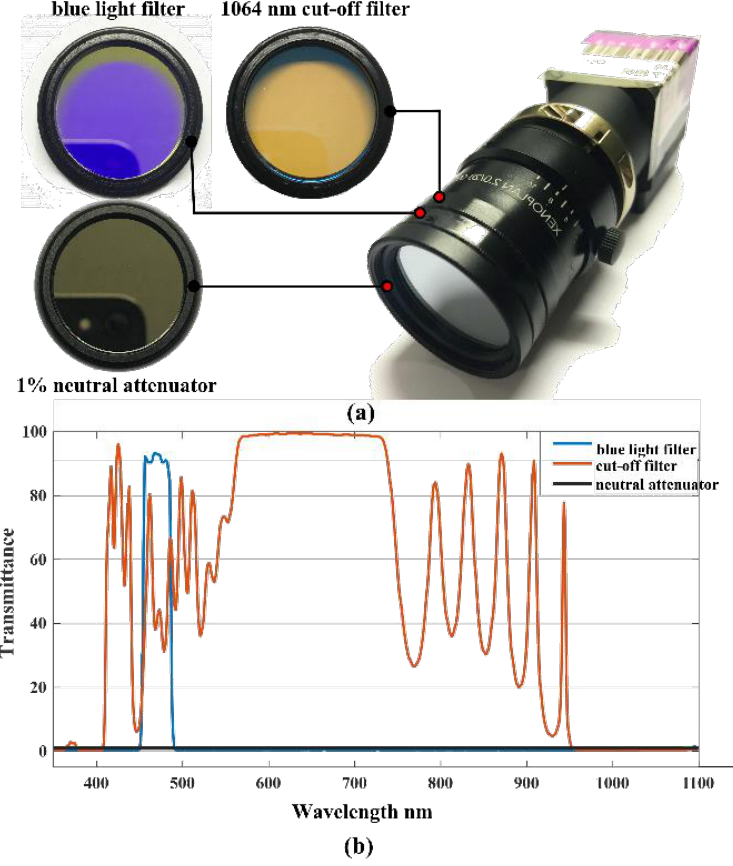
Figure 5. Filter group: ( a ) filter assembly sequence and ( b ) transmittance of different wave bands of